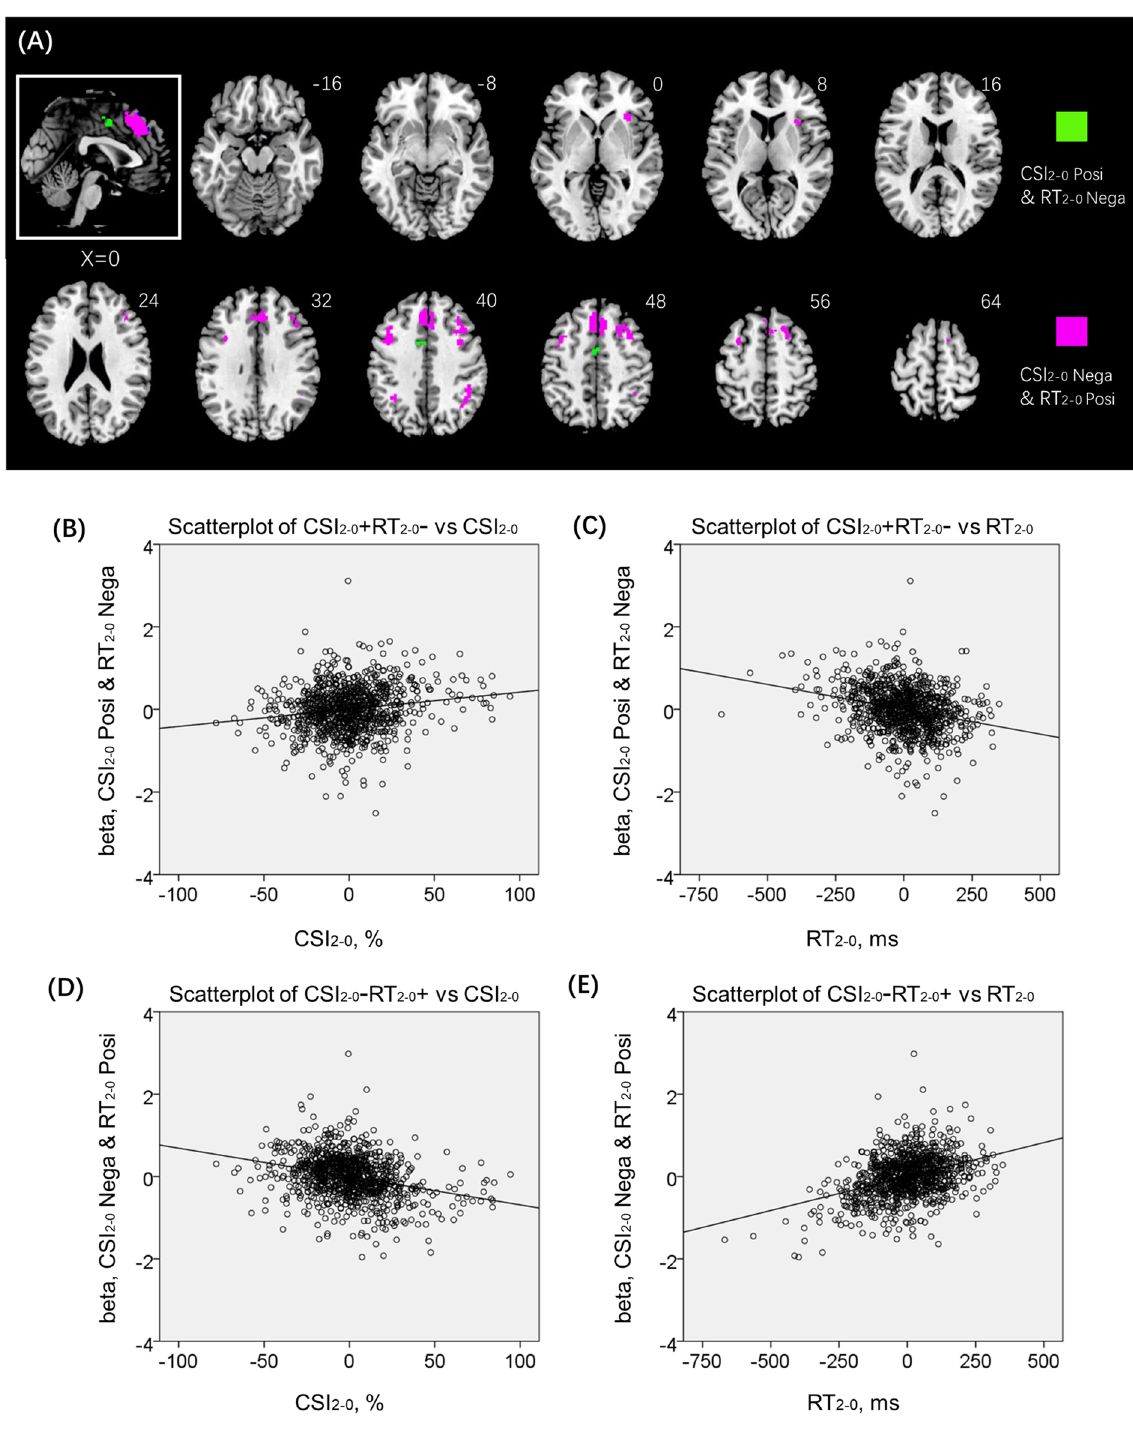
Figure 5. ( A ) A number of clusters showed positive correlation with CSI 2–0 and negative correlation with RT 2–0 (CSI + RT −), highlighted in green, or negative correlation with CSI 2–0 and positive correlation with RT 2–0 (CSI − RT +), highlighted in magenta. The CSI + RT − cluster comprised solely of the dACC. Linear regression of ( B ) beta estimates of green cluster (CSI + RT −) vs. the difference in CSI between 2- and 0-back: CSI + RT − vs. CSI 2–0 ; ( C ) beta estimates of green cluster (CSI + RT −) vs. the difference in RT of correct trials between 2- and 0-back: CSI + RT − vs. RT 2–0 ; ( D ) CSI − RT + vs. CSI 2–0 ; and ( E ) CSI − RT + vs. RT 2–0 . Note that the scatter plots show the residuals, after age, sex, and years of education were accounted for. ( B – E ) were generated by SPSS Statistics 22.0 (https:// www. ibm. com/ suppo rt/ pages/ spss- stati stics- 220- avail able- downl